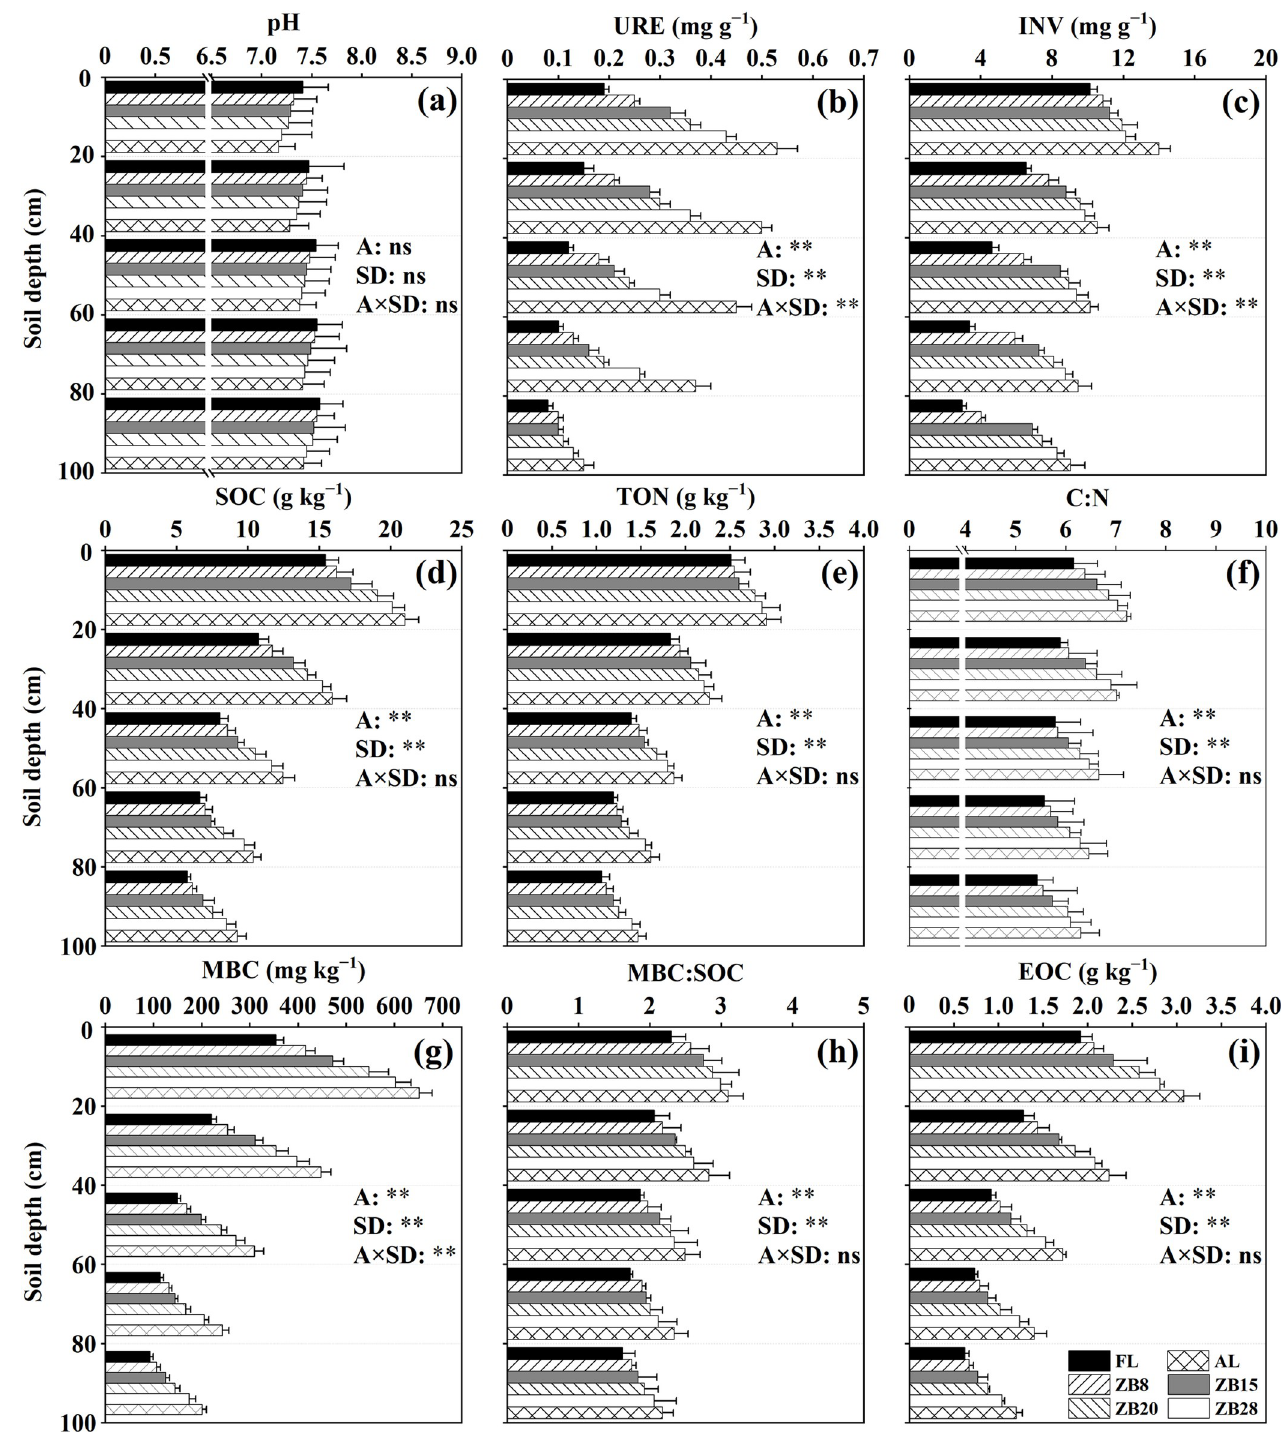
Fig 3. Basic chemistry and enzyme properties of soil in different years of returning farmland. Error bars represent standard deviations ( n = 3). Significant differences for main effects of sites (A), soil depth (SD) and their interactions are shown at � : p < 0.05, �� : p < 0.01, ns: p > 0.05.